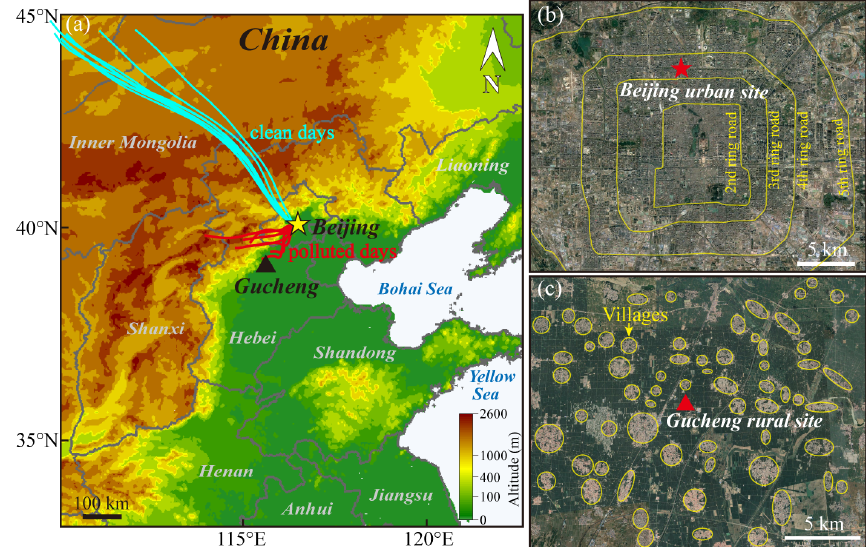
Figure 1. Locations of Beijing and Gucheng in the North China Plain (a) and the expanded view of surrounding topographies around the Beijing urban site (b) and Gucheng rural site (c) . The 24h backward trajectories of air masses ending at the height of 100ma.g.l. over the Beijing urban site on clean days (20–23 November) and polluted days (24–27 November) during the observation are also shown in panel (a) . Map copyright © 2020 Google